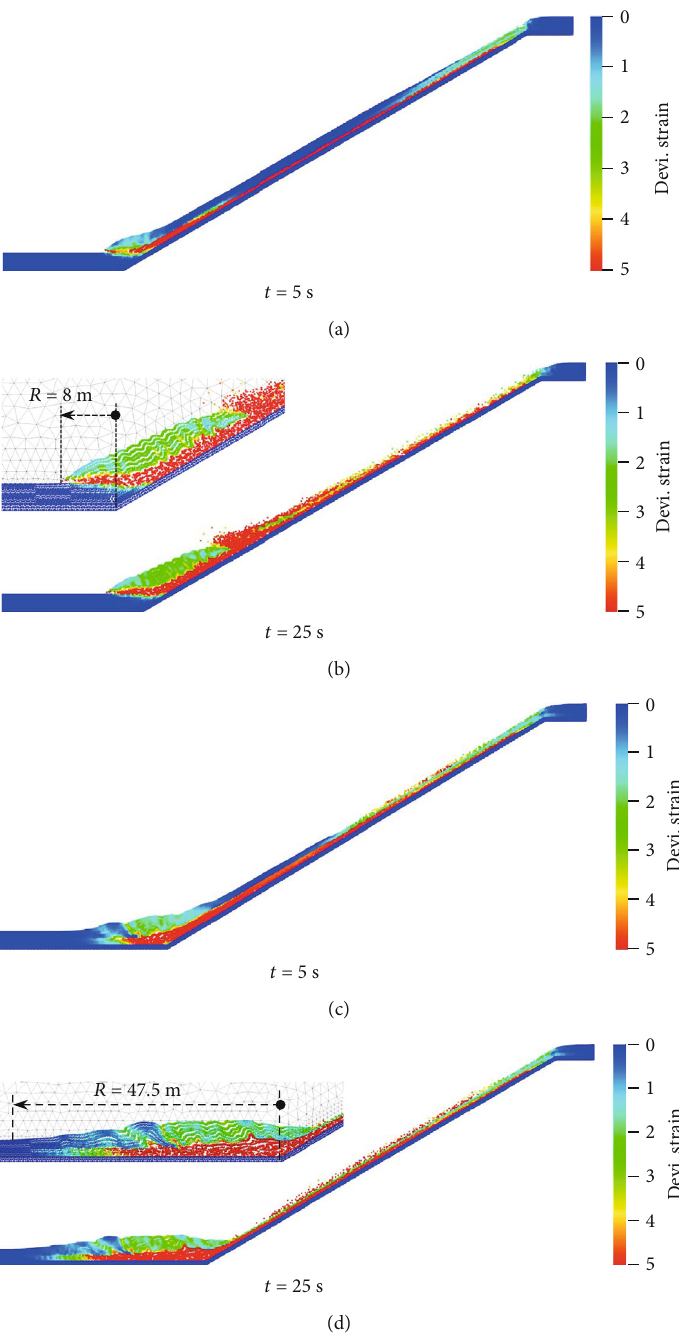
= 1 × 10 − 4 m/s and (c, d) k = 1 × 10 − 5 m/s s s